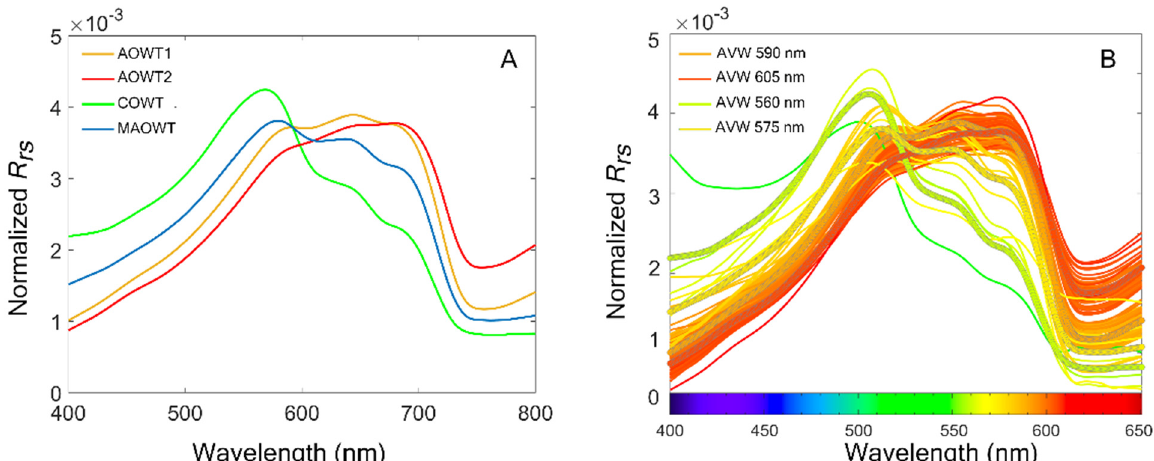
Figure 5. ( A ) Average normalized R rs spectra resultant from the k -means clustering analysis of the Lower Amazon region; ( B ) AVW values derived from the normalized in situ R rs spectra (400–800 nm), yielding a range of values from 543 nm to 612 nm. The thicker lines with circle markers are referred to the central AVW according to the k- means classes.